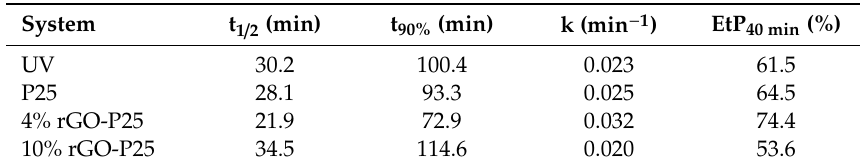
Table 9. Experimental results obtained from EtP photodegradation with the UV / rGO-P25